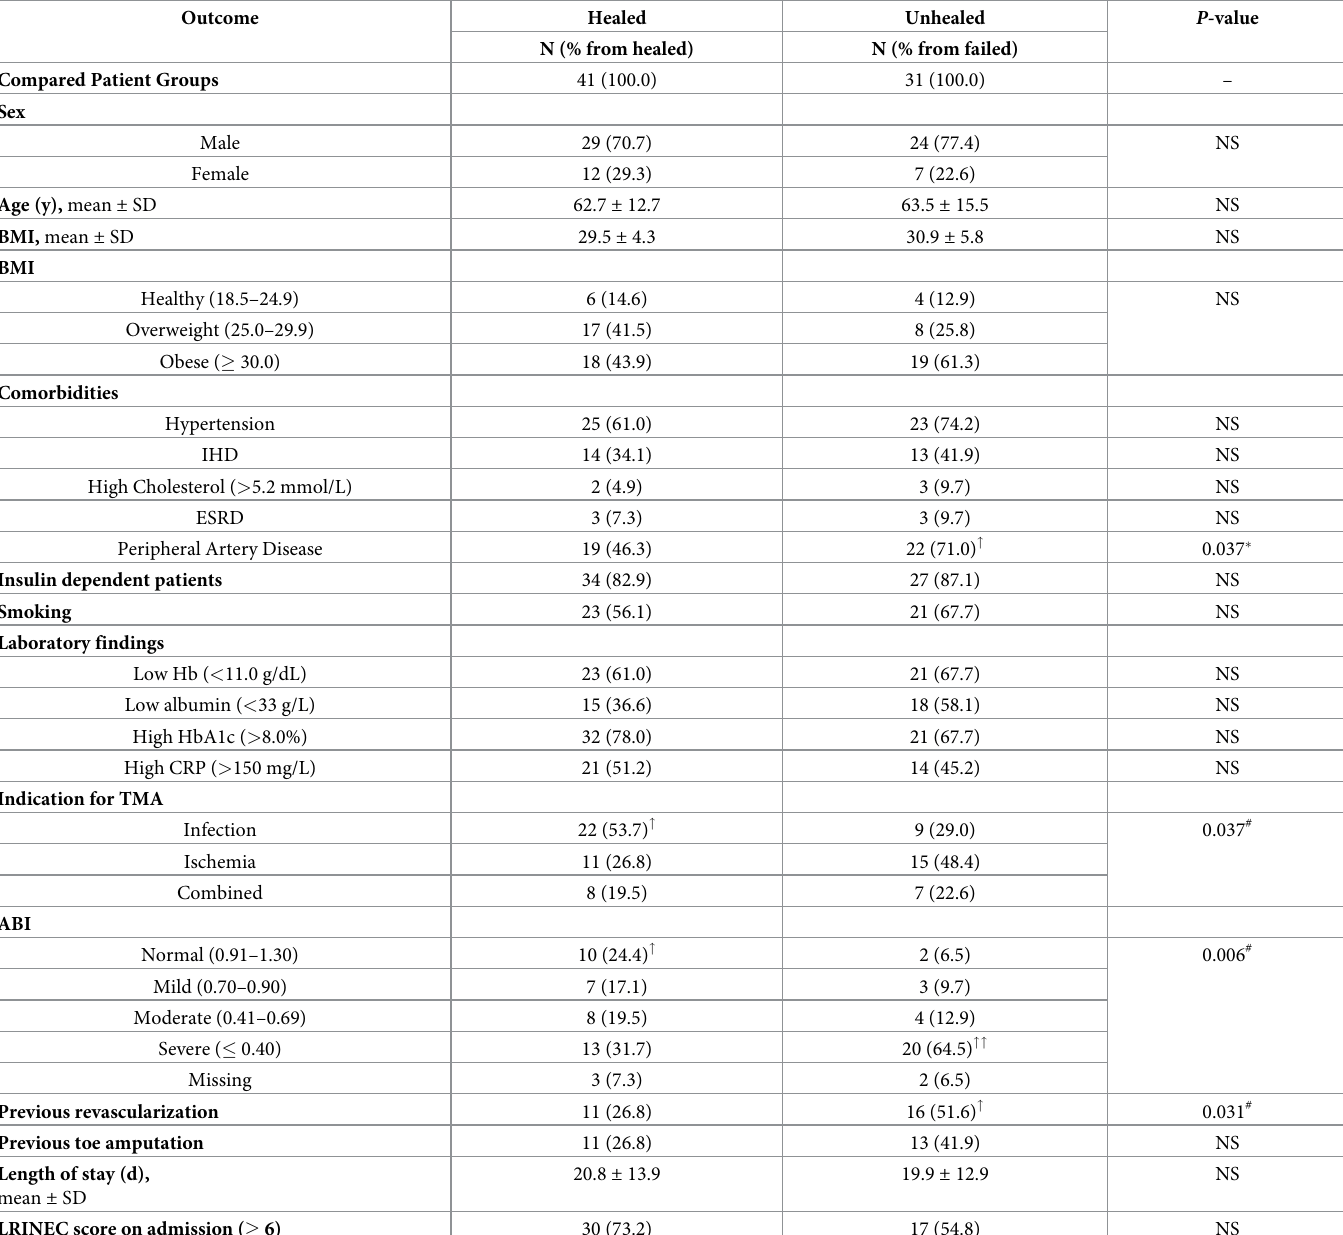
Table 2. Factors associated with the outcome of transmetatarsal amputation (TMA) in diabetic